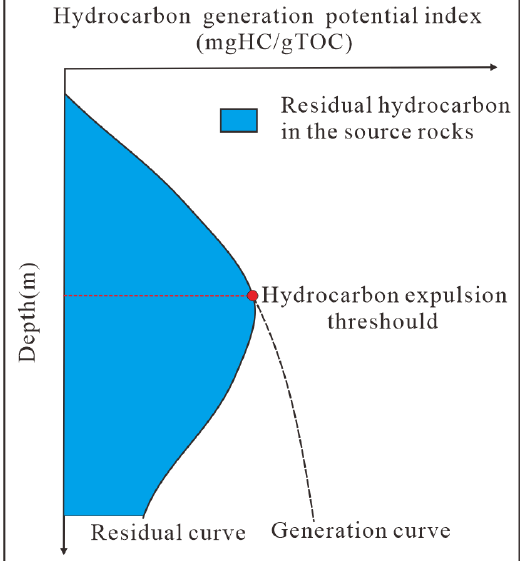
Figure 2. Determination of HET model based on the variation of HGP index with depth, modified after [36].